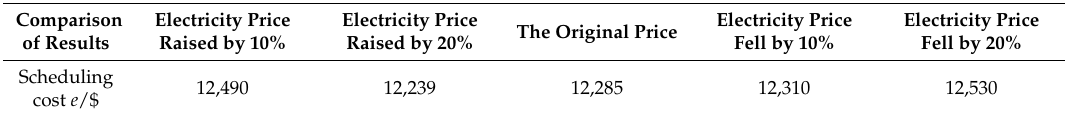
Table 13. Scheduling cost under different electricity price.